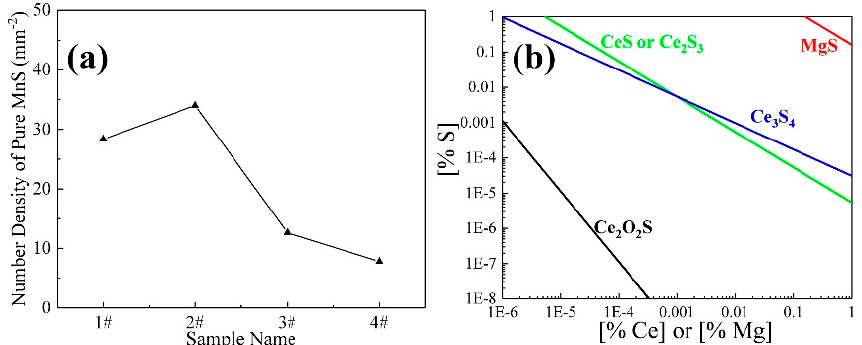
Figure 2. ( a ) Number density of pure MnS in the as-cast samples; ( b ) desulphurization curves of Mg and Ce in 1873 K with 0.004% [O].